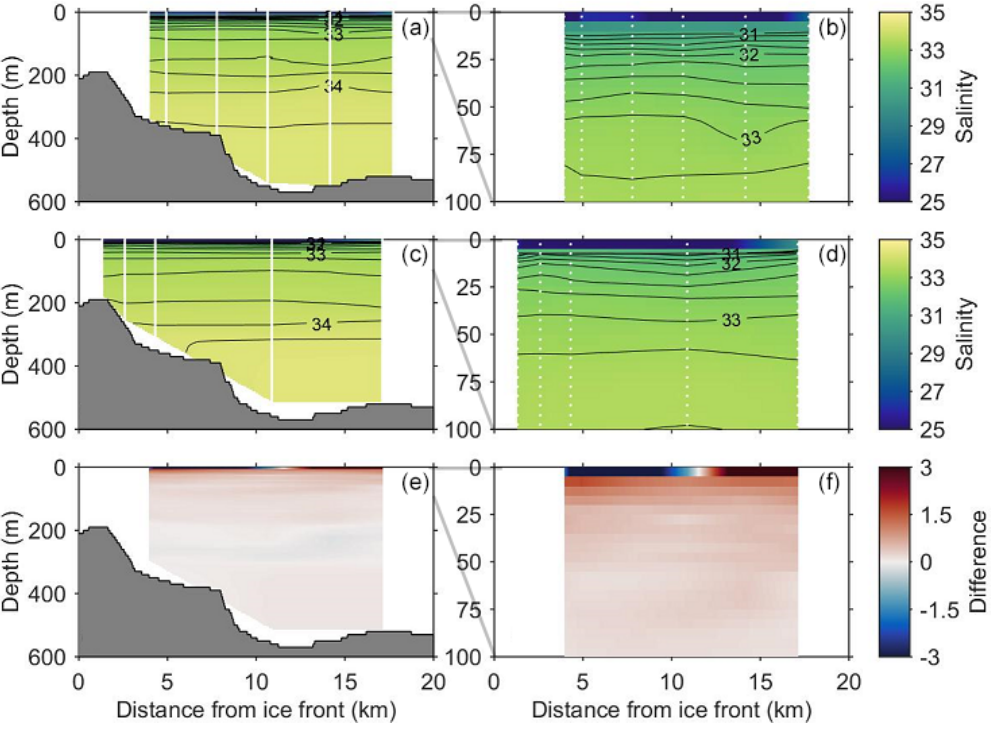
Figure 4. Same as Fig. 3 but for